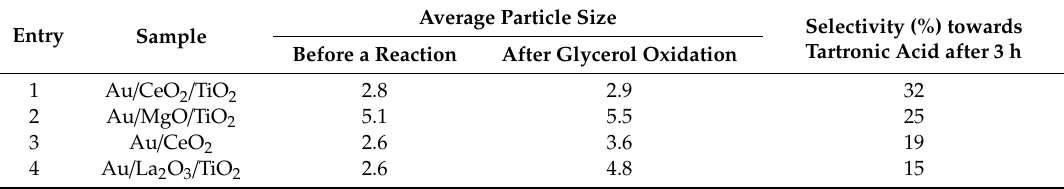
Figure 5. HRTEM images and the particle size distribution of the used gold catalysts after glycerol oxidation reaction (T = 50 °C, 0.3 M Glycerol (H ₂ O), NaOH/glycerol = 4 eqv., R = 1000, 1100 rpm stirring rate, 3 h). Table 6. Comparison of mean diameter of gold catalysts before and after glycerol oxidation reaction.